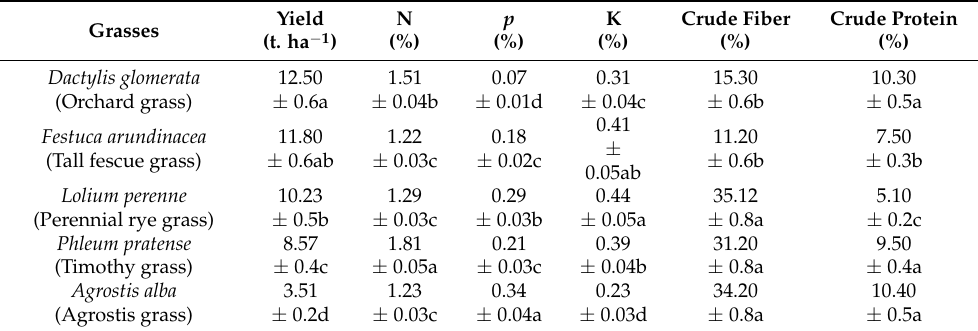
Table 7. Yield and leaf nutrient profile of prominent grasses.